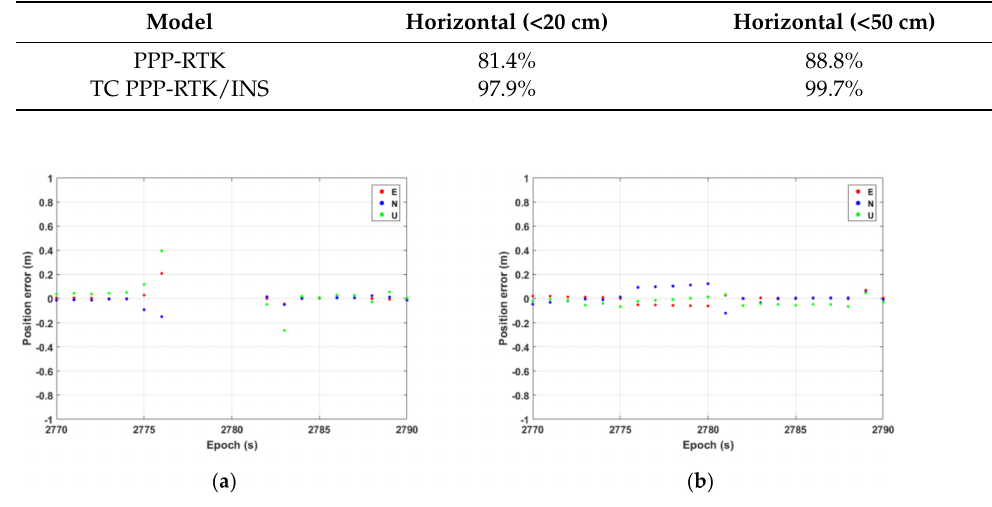
Figure 10. The percentage of horizontal positioning error that does not exceed the specified threshold in experiment B. Table 5. Positioning availability in the horizontal component of PPP-RTK and TC PPP-RTK/INS in experiment B.